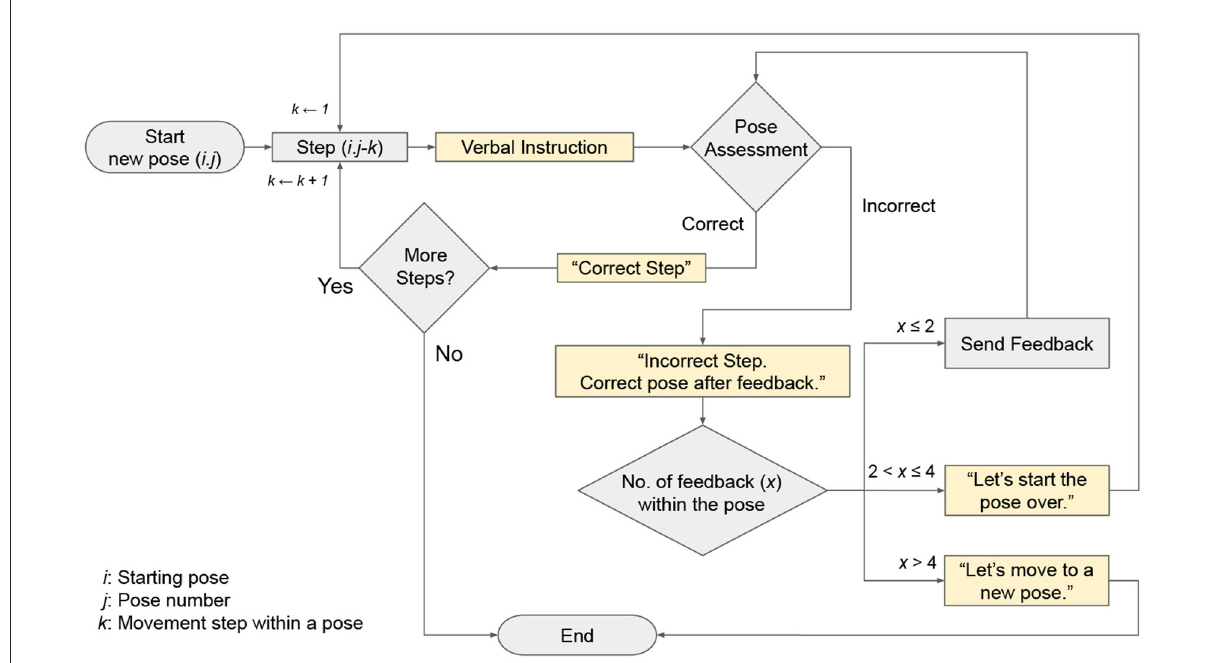
FIGURE1 Sequence of decisions made in system for sending verbal notifications and feedback during yoga.